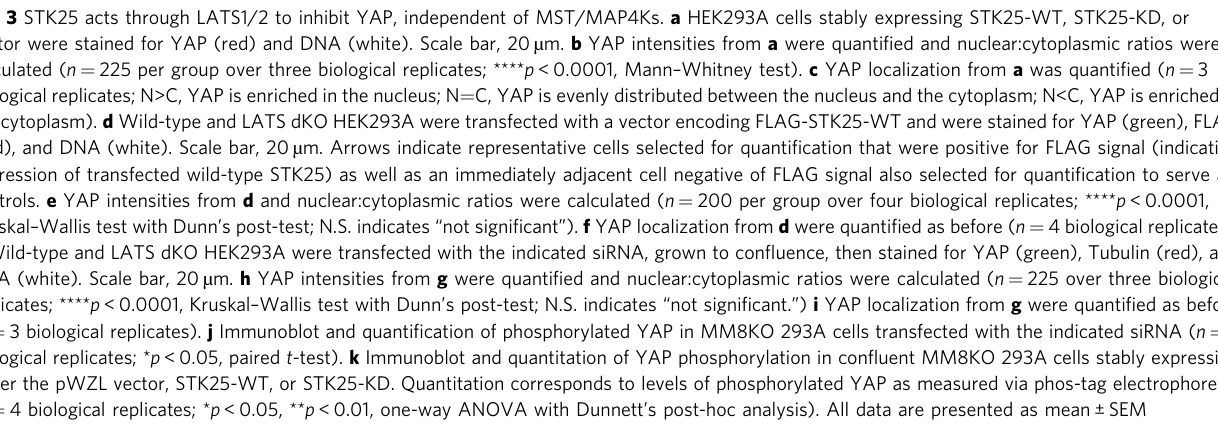
Fig. 3 STK25 acts through LATS1/2 to inhibit YAP, independent of MST/MAP4Ks. a HEK293A cells stably expressing STK25-WT, STK25-KD, or vector were stained for YAP (red) and DNA (white). Scale bar, 20 µ m. b YAP intensities from a were quanti fi ed and nuclear:cytoplasmic ratios were calculated ( n = 225 per group over three biological replicates; **** p < 0.0001, Mann – Whitney test). c YAP localization from a was quanti fi ed ( n = 3 biological replicates; N>C, YAP is enriched in the nucleus; N = C, YAP is evenly distributed between the nucleus and the cytoplasm; N<C, YAP is enriched in the cytoplasm). d Wild-type and LATS dKO HEK293A were transfected with a vector encoding FLAG-STK25-WT and were stained for YAP (green), FLAG (red), and DNA (white). Scale bar, 20 µ m. Arrows indicate representative cells selected for quanti fi cation that were positive for FLAG signal (indicating expression of transfected wild-type STK25) as well as an immediately adjacent cell negative of FLAG signal also selected for quanti fi cation to serve as controls. e YAP intensities from d and nuclear:cytoplasmic ratios were calculated ( n = 200 per group over four biological replicates; **** p < 0.0001, Kruskal – Wallis test with Dunn ’ s post-test; N.S. indicates “ not signi fi cant ” ). f YAP localization from d were quanti fi ed as before ( n = 4 biological replicates). g Wild-type and LATS dKO HEK293A were transfected with the indicated siRNA, grown to con fl uence, then stained for YAP (green), Tubulin (red), and DNA (white). Scale bar, 20 µ m. h YAP intensities from g were quanti fi ed and nuclear:cytoplasmic ratios were calculated ( n = 225 over three